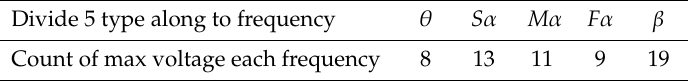
Figure 2. Sample result of measured brain wave of one second. Table 1. Sample result of the total number in one minute of brain waves that appeared most strongly in the spectrum calculated every second.